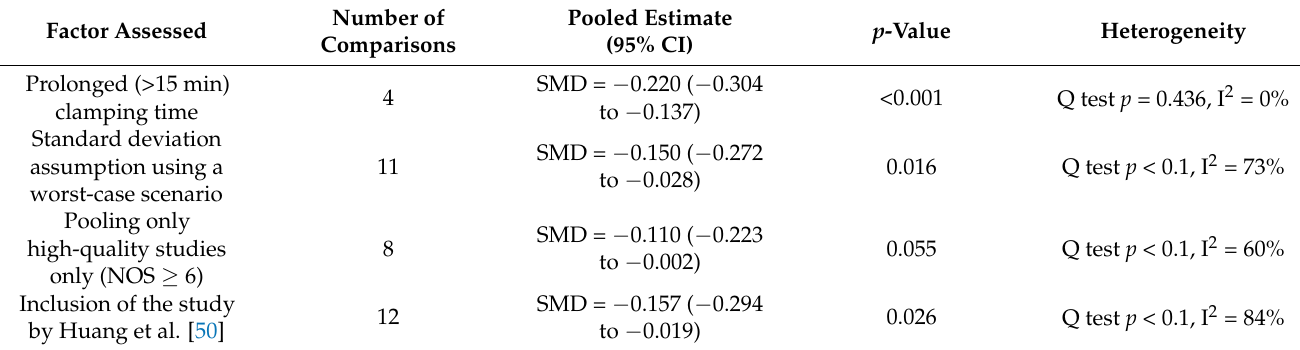
Table 3. Results of the sensitivity analyses.